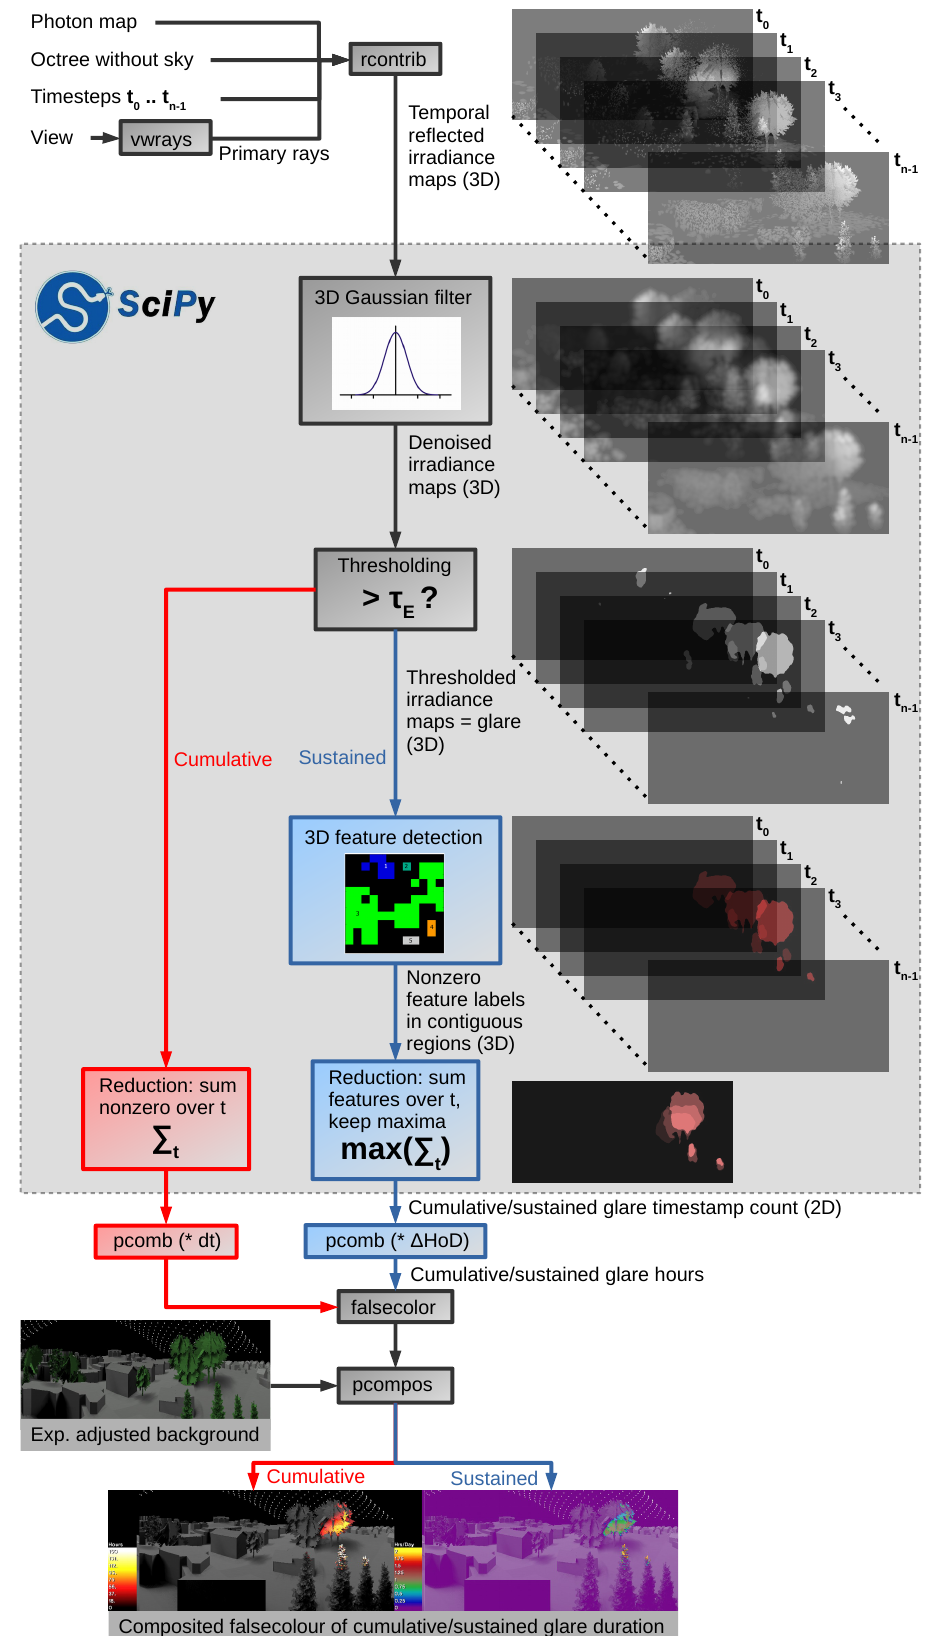
Figure 5. Spatio-temporal PV reflection simulation workflow to assess glare